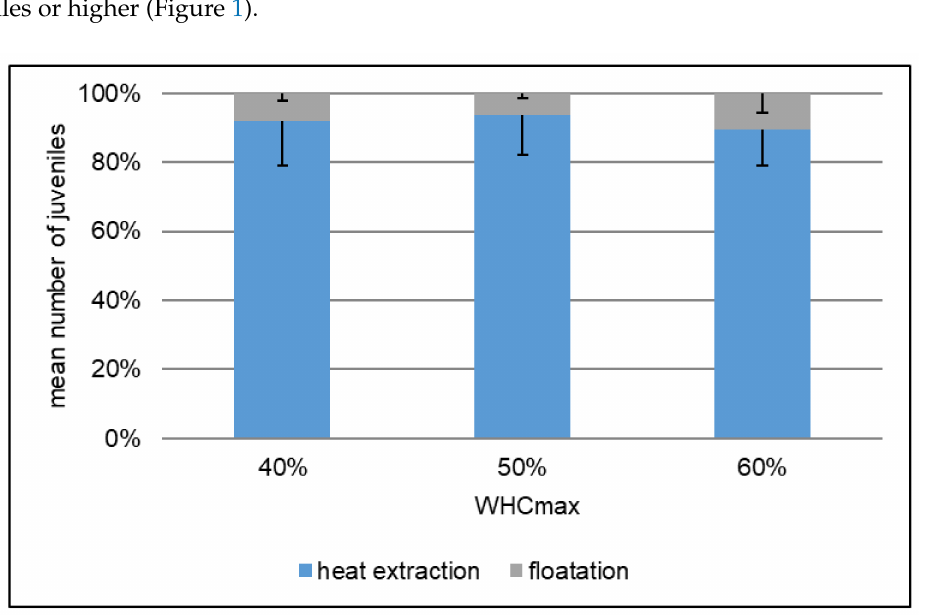
Figure 1. Extraction efficiency of the dynamic heat extraction at different soil water